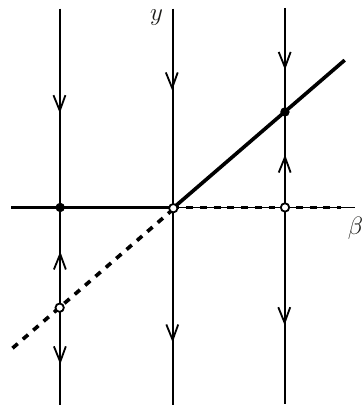
Figure 23. Transcritical bifurcation in the system _ y = (cid:12)y